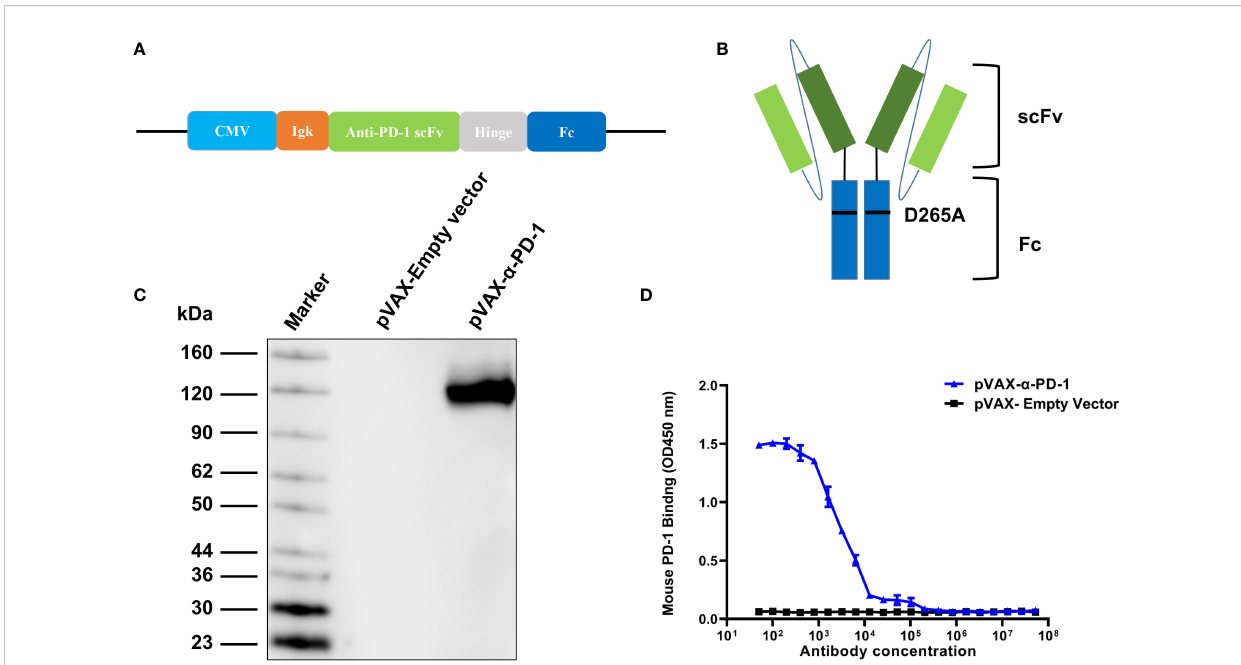
FIGURE 1 Expression and binding of PD-1 antibody. (A) Schematic of DNA construct encoding PD-1 antibody. The a - PD-1-Fc gene was cloned onto the pVAX vector and driven by the CMV promoter. (B) Structure of PD-1 antibody. a -PD-1-Fc contained scFv of mouse PD-1 antibody and the Fc region of mouse IgG1 with a D265A mutation. (C) Western blot analysis of mouse IgG from supernatants of pVAX- a -PD-1-Fc transfected 293T under non- reduced conditions. The pVAX-empty vector served as a control. Numbers indicate molecular weight. (D) The binding ELISA of a -PD-1-Fc from cell culture supernatants with mouse PD-1 antibodies. Results are representative means ± SDs of three independent